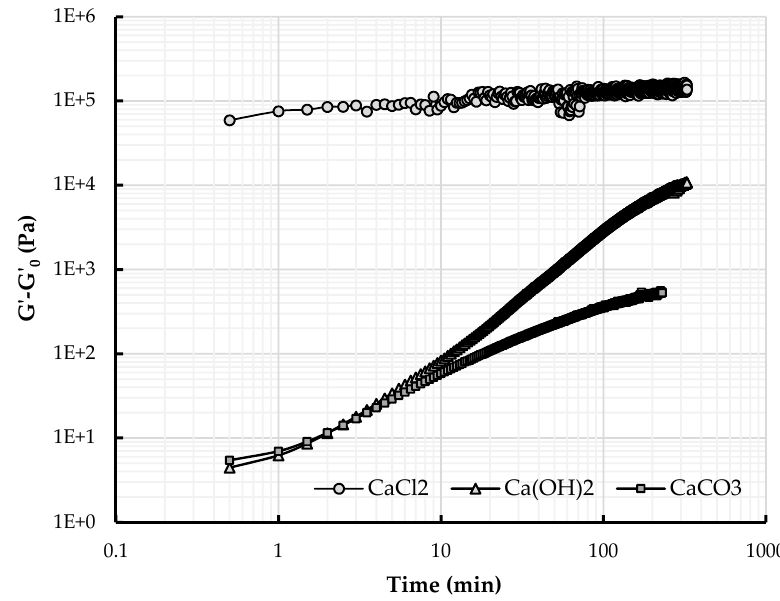
Figure 6. Variation of the storage modulus for earth pastes prepared with 0.2% NaHMP and different calcium products. Values are reported as a difference with respect to G 0 , the modulus of the paste without addition of calcium compounds at each measuring time.